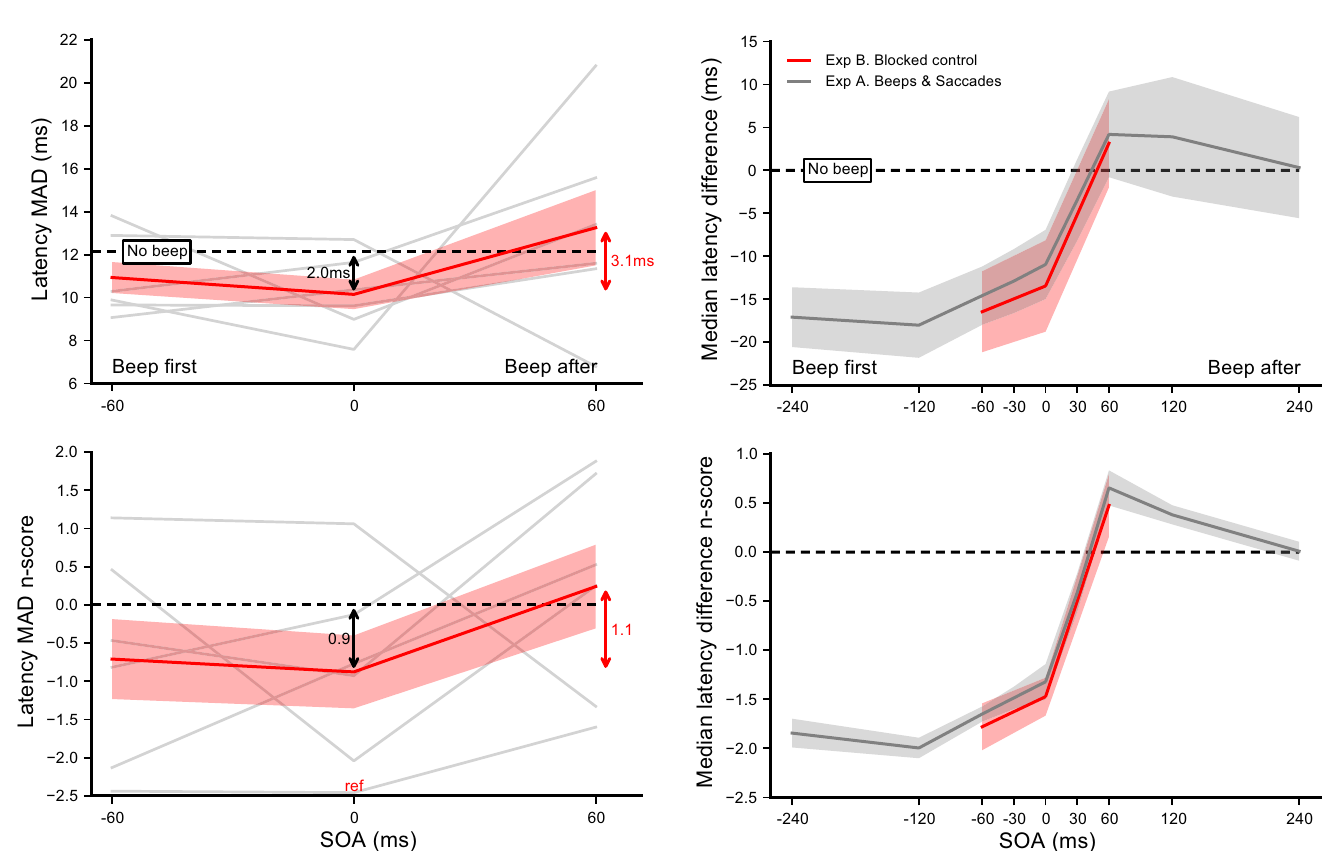
Fig 3. Experiment B. Effect of sound beeps on saccade onset with blocked conditions (left panel). Median latencies averaged across participants for each SOA condition (top) and the corresponding n scores (bottom). Dashed lines show the No beep condition level and grey lines show individual data. Error bars indicate inter- individual SEM. Statistics included a single sample t-test performed on the n scores of the SOA = 0 ms reference condition to highlight the difference with the No beep condition (black arrow), and two paired t-tests comparing this reference with SOA = − 60 or +60 ms conditions (red stars above the X-axis). Interleaved vs. blocked conditions (right panel). Comparison between experiment B (red plot) and A (grey plot): median latency differences (top) and n score differences (bottom) aligned on the No beep condition (dashed lines). Unpaired t-tests performed on the n score differences between experiments for the 3 SOA conditions showed no significant difference. Three stars indicate highly significant differences after Bonferroni correction (p < 0.01666). Red arrows indicate the overall range of variations.